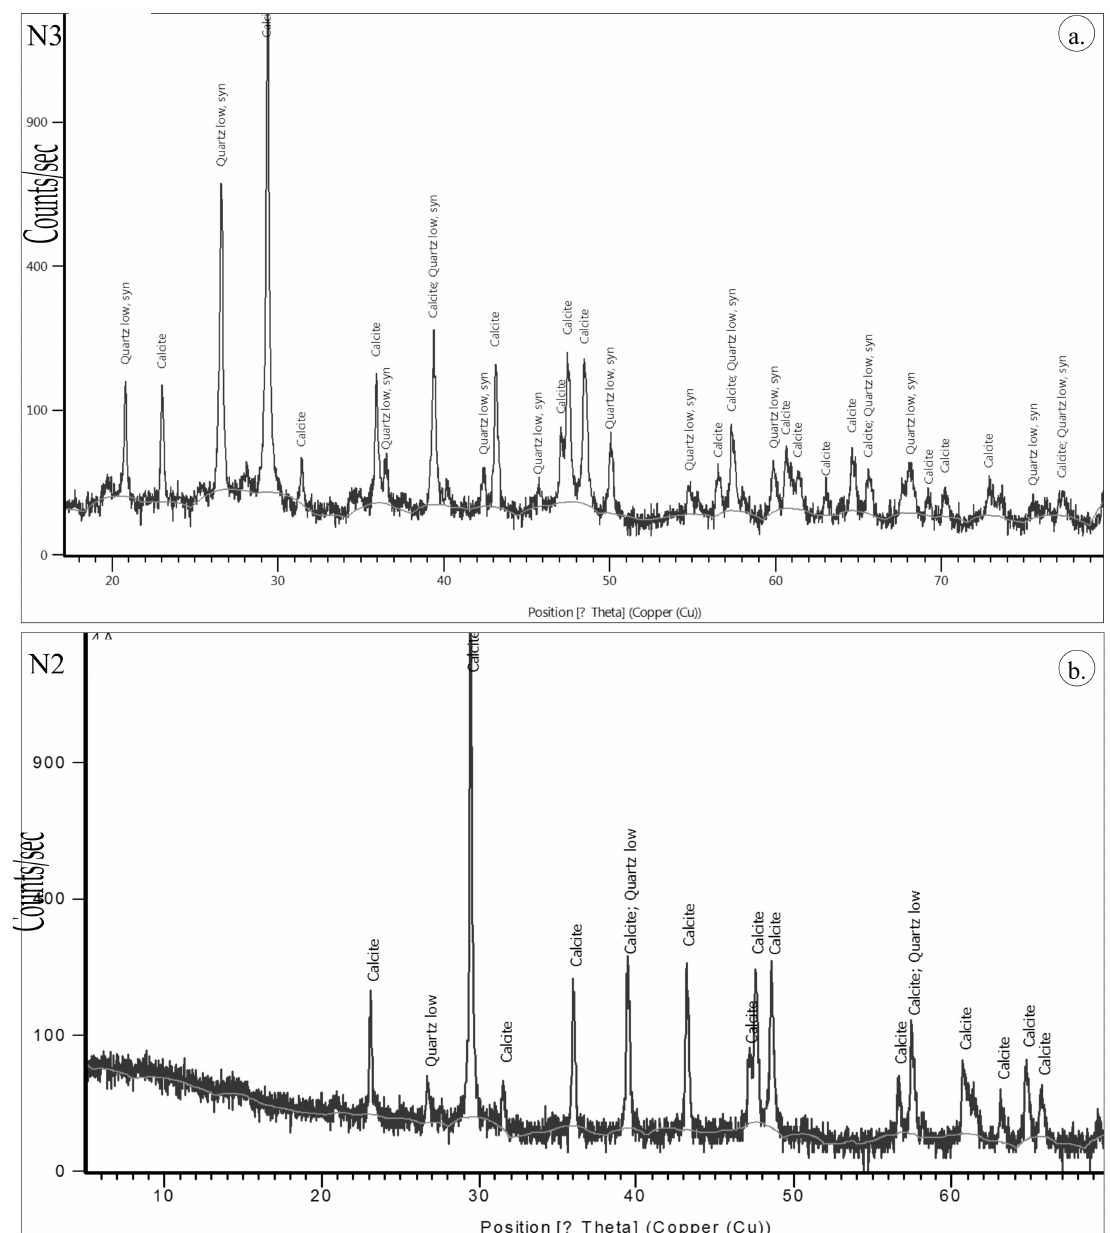
Figure 6. XRD analysis shows the presence of calcite minerals in the exotic limestones of Nakhl